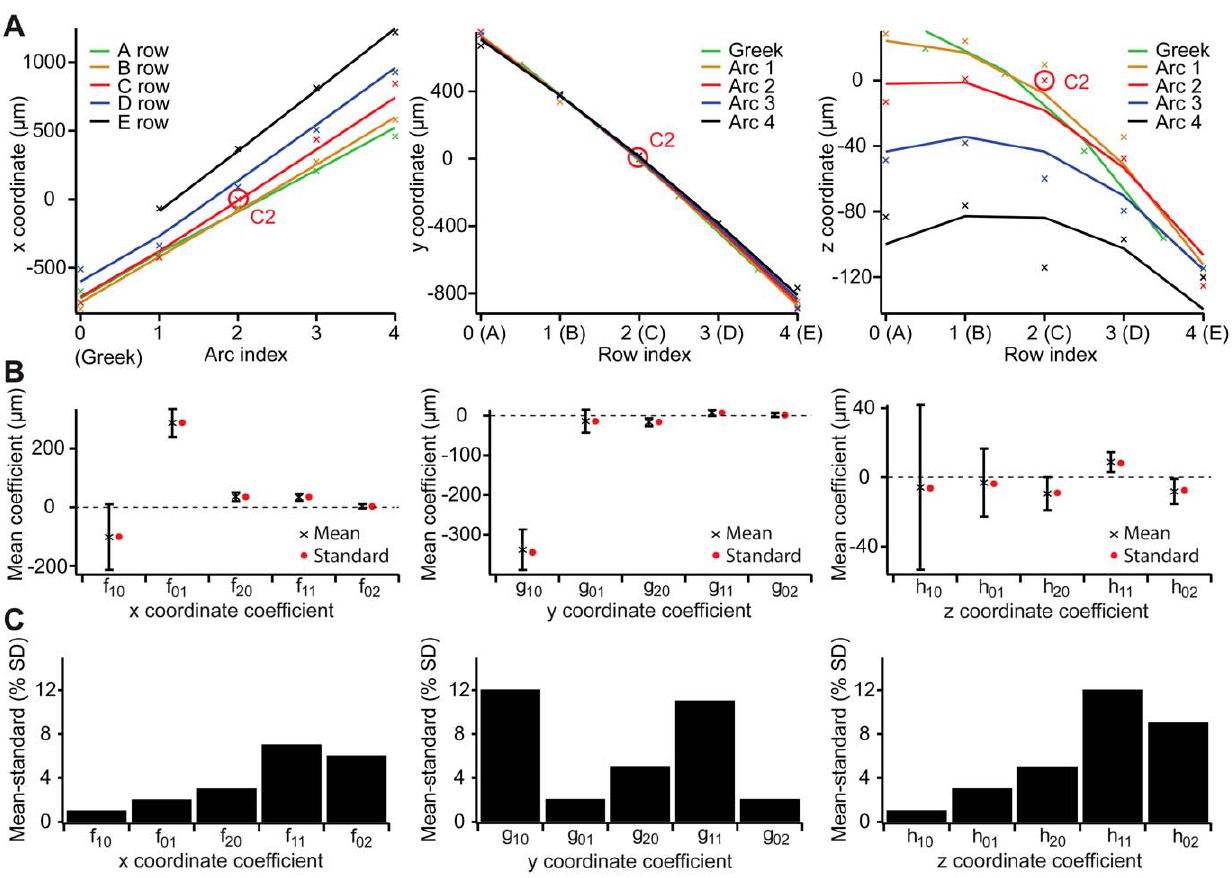
Figure 7. Quantitative description of the 3D anatomical layout of the barrel field. (A) Fits of 2 nd order polynomials in (Row, Arc) coordinates to the x/y/z coordinates of the BC points of the standardized barrel field. (B) Mean coefficients (black) of the fits to all reconstructed barrel fields and coefficients of the fit to the standardized barrel field (red). Error bars are 6 1 standard deviation. (C) Difference between the mean coefficients and the coefficients of the standardized barrel field in units of standard deviation.